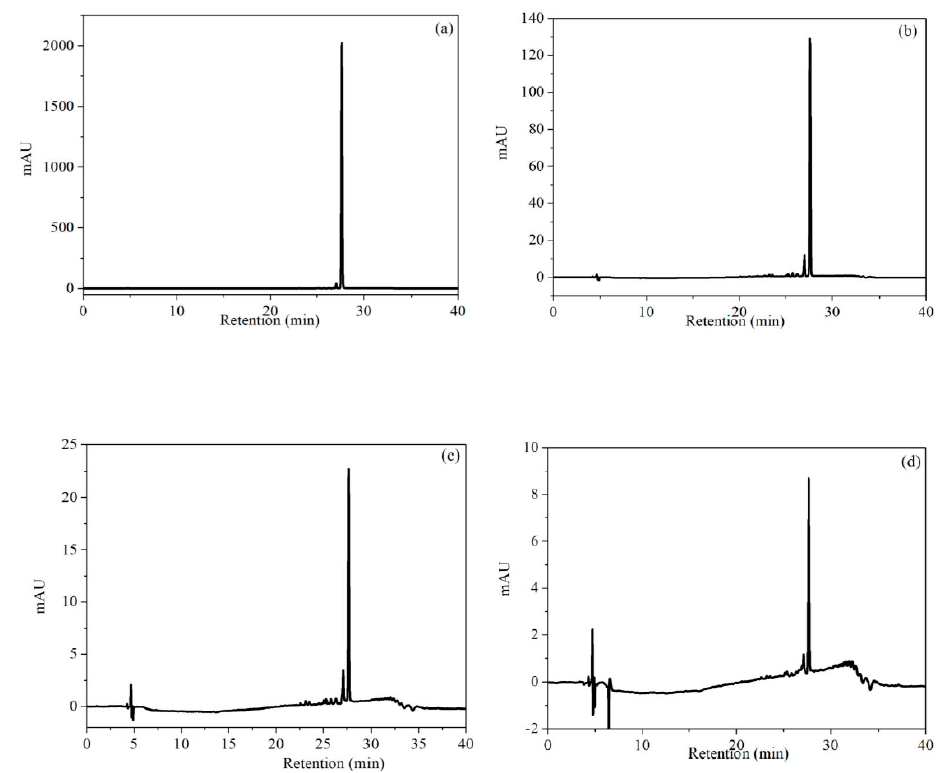
Figure 10. HPLC chromatograms of RhB and its intermediate products in photocatalytic degradation for different reaction time: ( a ) 0 min; ( b ) 10 min; ( c ) 20 min; ( d ) 40 min.